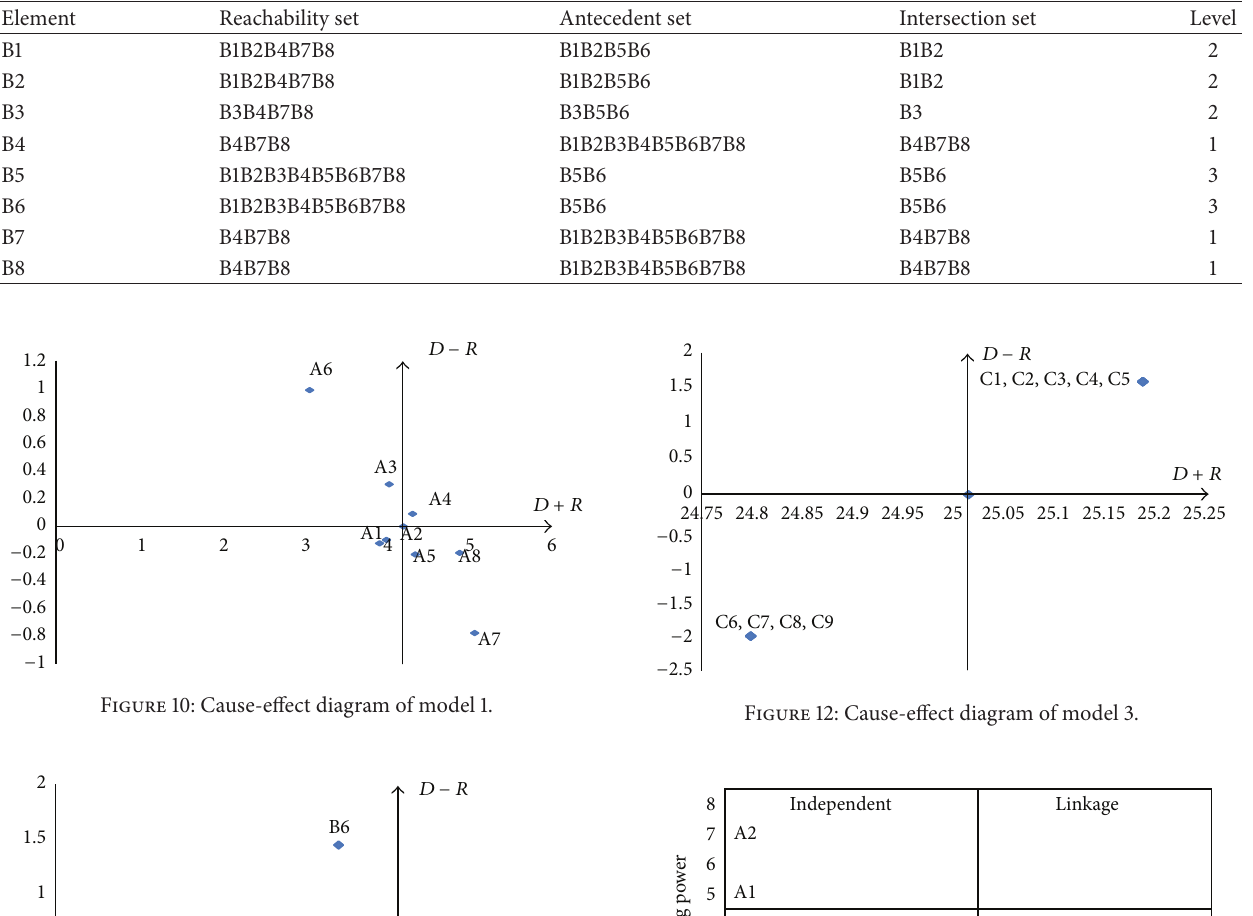
Table 4: Levels of model 2 elements.